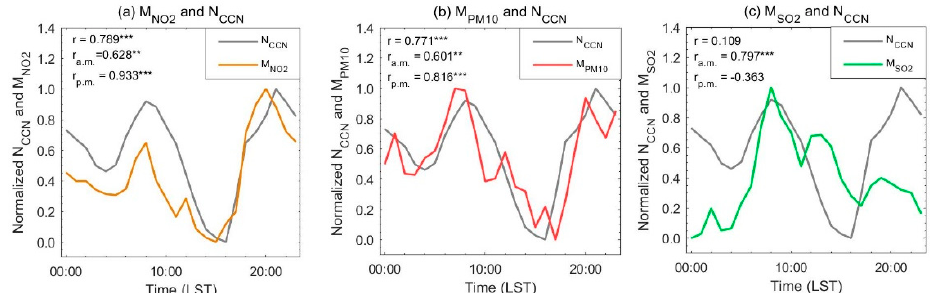
Figure 3. The diurnal variations of normalized pollutants and N CCN values in winter 2007, including ( a ) M NO2 , ( b ) M PM10 , and ( c ) M SO2 , respectively. The Pearson correlation coefficients for the whole day (r), a.m. (r a.m. ), and p.m. (r p.m. ) are shown in the top left of each graph. Superscripts *** and ** indicate that the fitting parameters pass the consistency test under the significance levels of 99% and 95%, respectively.